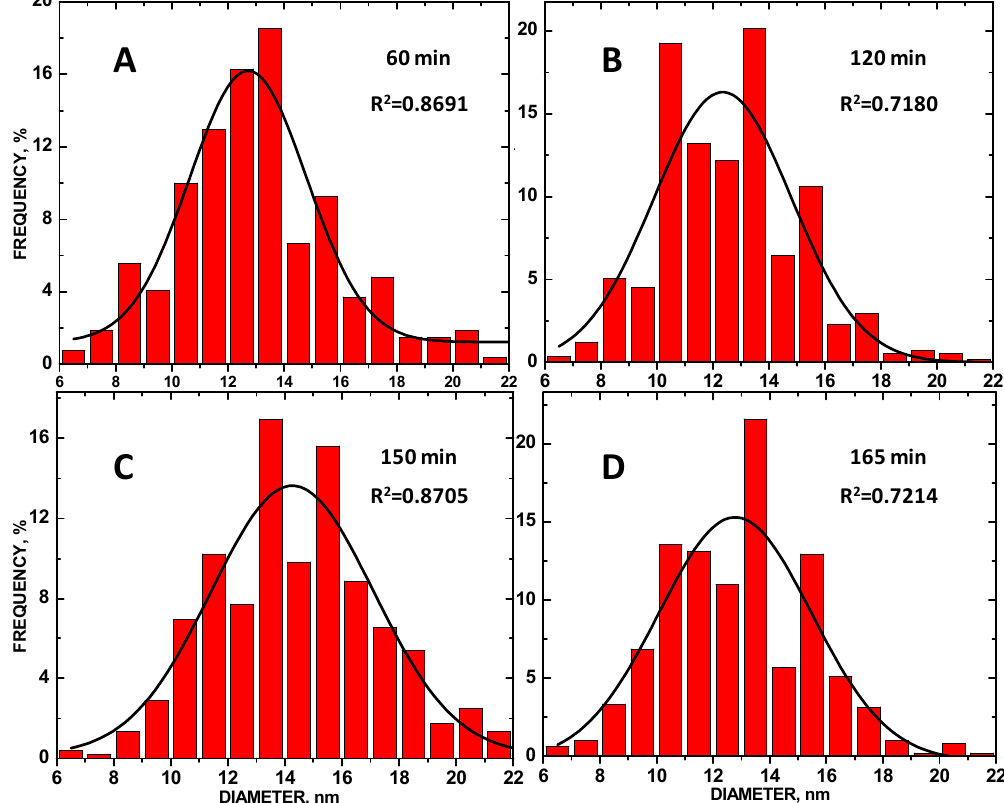
Figure 4. Size histograms of tethered ZnO NPs tethered to the COOH-MWNT surface of the MWNTs, produced at ( A ) 60, ( B ) 120 min, ( C ) 150, and ( D ) 165 min sonication times.